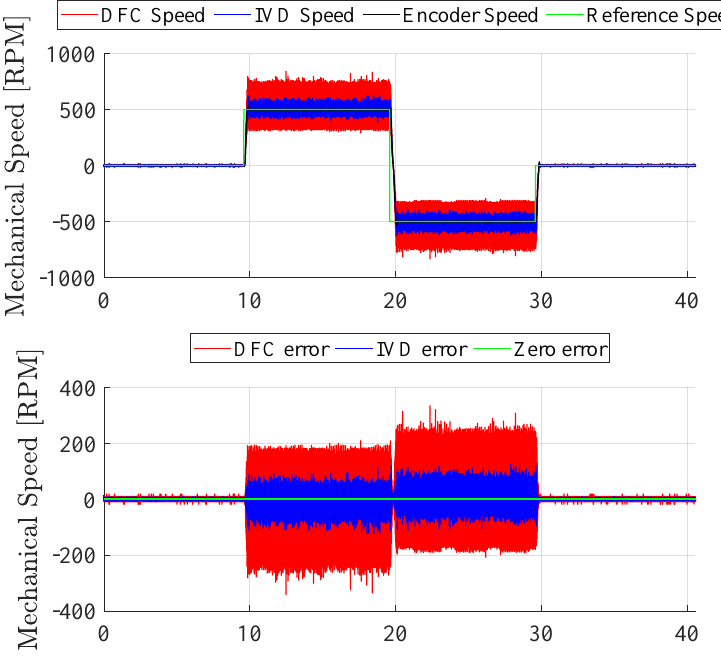
Figure 17. The DFC and IVD-DFC speed estimation are compared. The speed estima- tion error is shown below. The remaining noise on the IVD speed is not depending on the second harmonic.